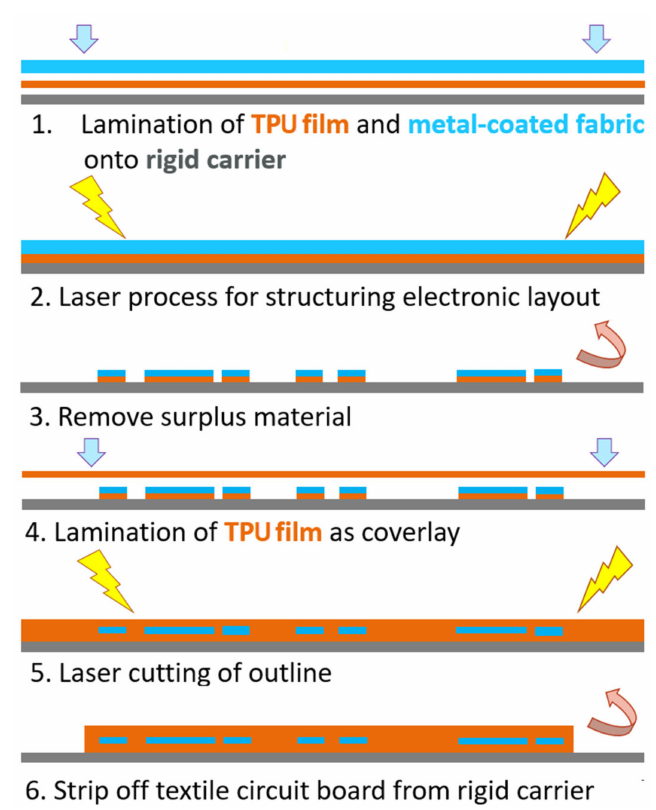
Figure 2. Process flow of stretchable circuit boards based on elastic textile / polymer composites.